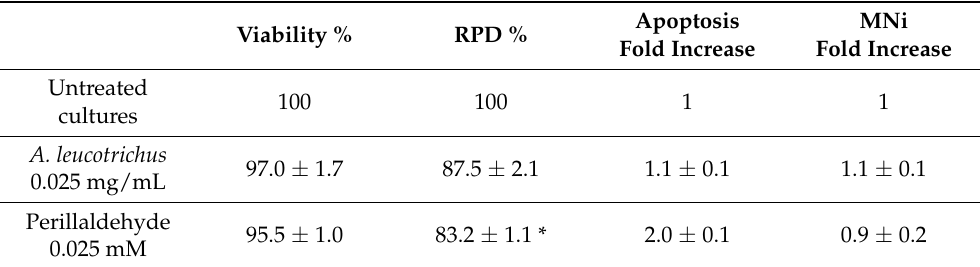
Table 2. Viability, RPD, apoptosis fold increase, and MNi fold increase on TK6 cells after 26 h treatments with A. leucotrichus at the indicated concentration compared to the untreated cultures. * p < 0.05 vs. untreated cultures. Apoptosis Viability % RPD % Fold Increase